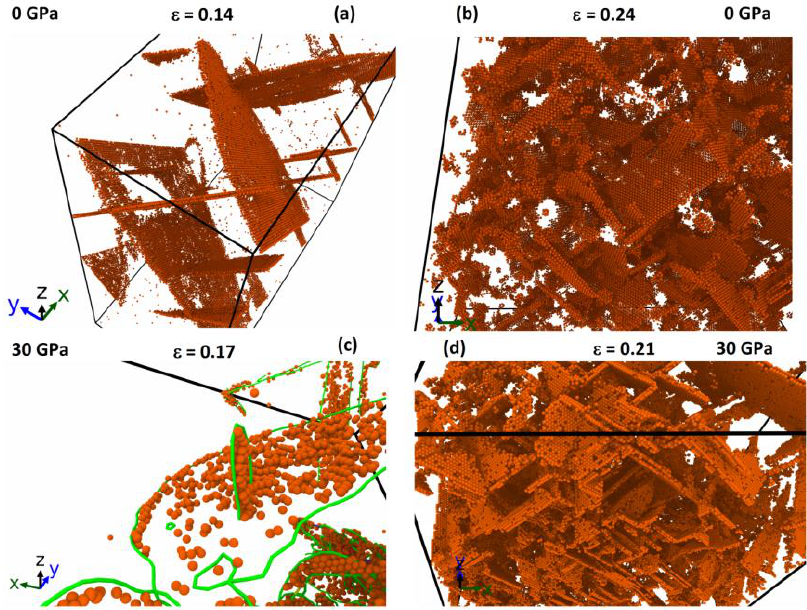
Figure 11. Development of plastic deformation in copper at initial pressure of: ( a , b ) 0 GPa and ( c , d ) 30 GPa. ( a ) Growth of loops of partial dislocations limiting the stacking faults; ( b ) generation of secondary perfect dislocations from the intersections of stacking fault and vacancy formation; ( c ) nucleation of primary loops of partial dislocations and stacking faults inside them and generation of secondary dislocations from stacking fault planes; ( d ) dislocation network.